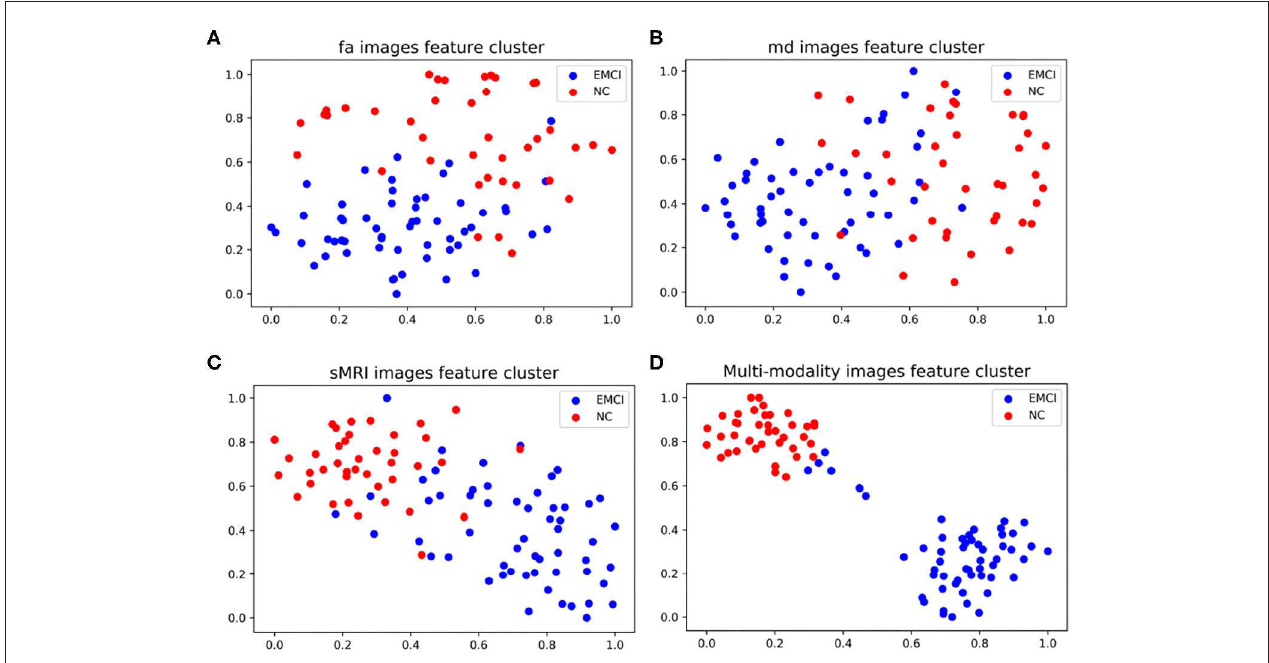
FIGURE 5 | Manifold visualization of different neuroimaging feature, by t-SNE projection (Laurens and Hinton, 2008). (A) FA features; (B) MD features; (C) sMRI features; and (D) the features fusing FA, MD, and sMRI.